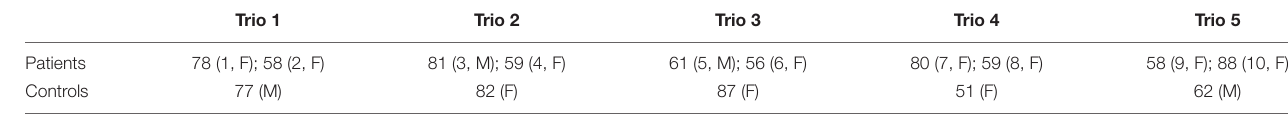
TABLE 1 | Demographic data of patients with neurodegenerative parkinsonism.